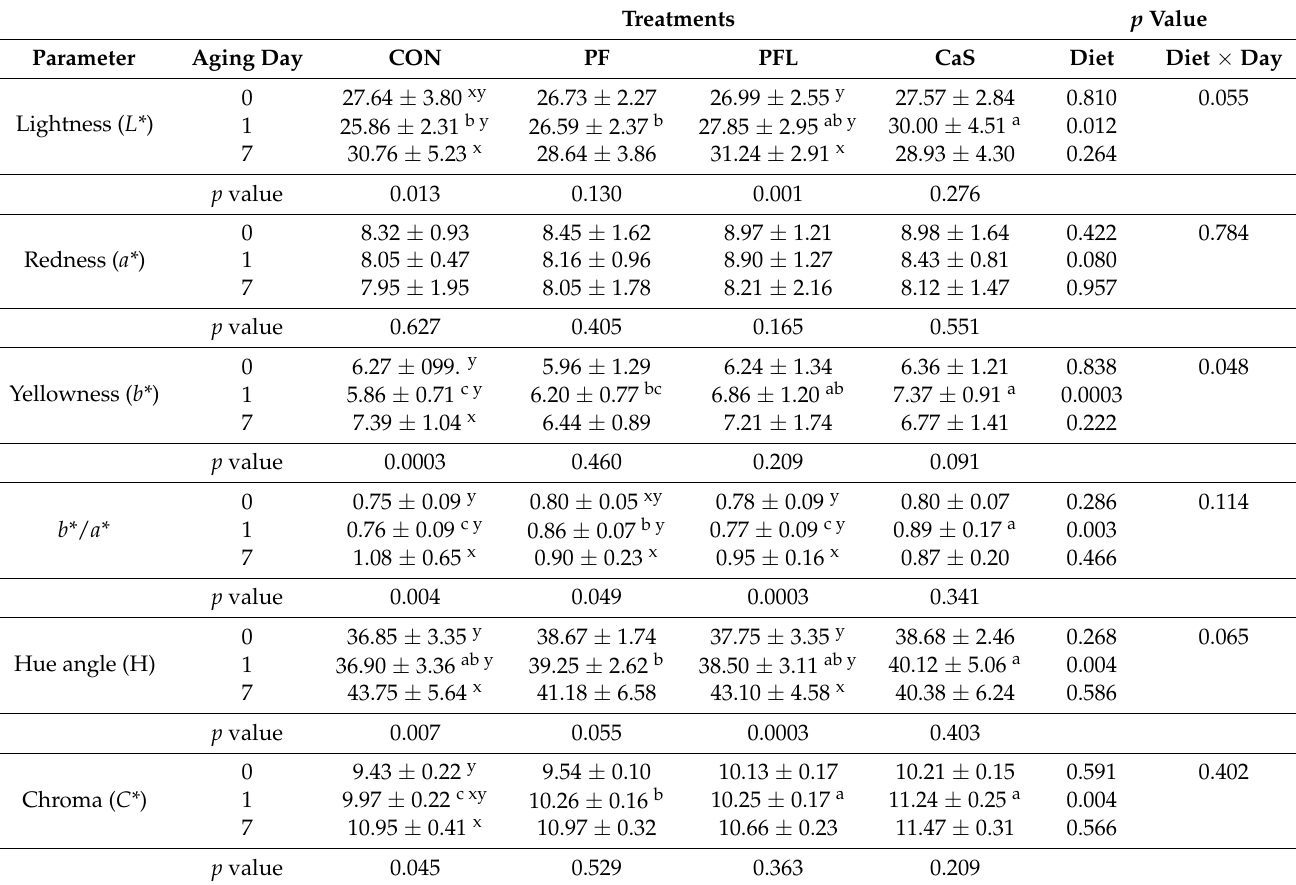
Table 4. Color coordinates of longissimus dorsi muscle in Dorper sheep at different aging days. Treatments p